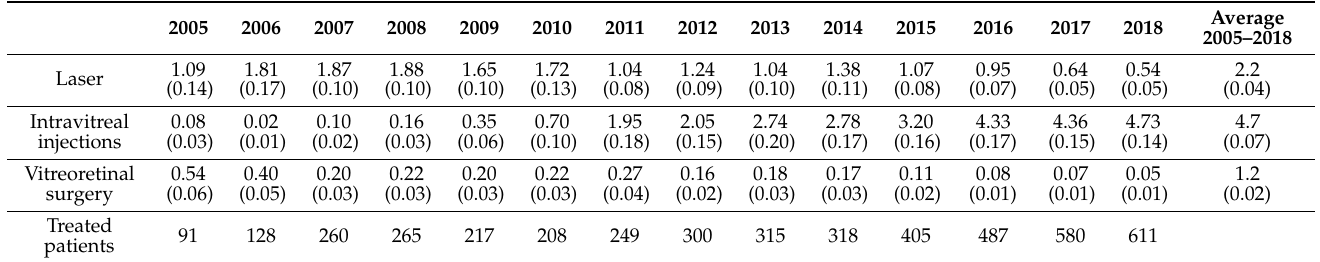
Table 2. Average number of treatment procedures (standard error) per patient per year and the total number of patients treated per year for diabetic